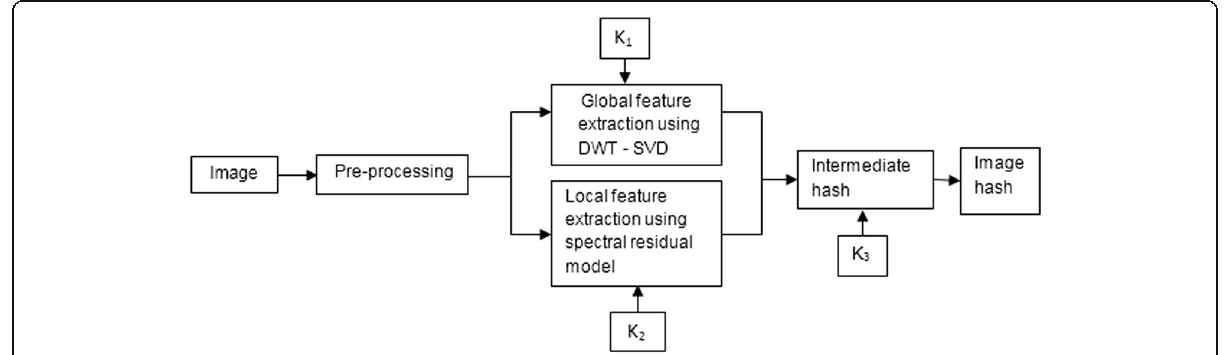
Fig. 1 Block diagram of proposed